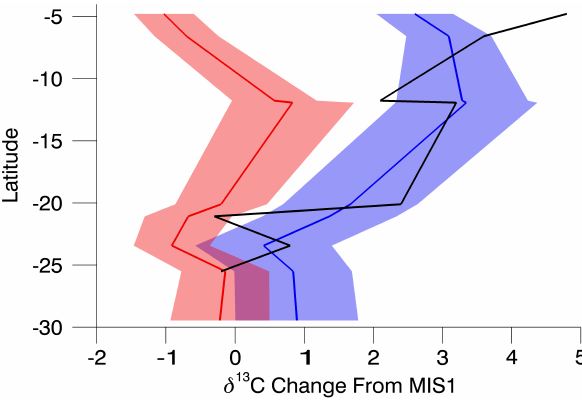
Fig. 2b. (b) Observed and simulated differences in δ 13 C values of leaf-wax n -alkanes. Black line: data, LGM minus Holocene. Sim- ulations: LGM with pre-industrial CO 2 minus PI (red); LGM with realistic CO 2 minus PI (blue). In both panels, simulated values are shown as means (coloured lines) and ranges (shading) across cli- mate